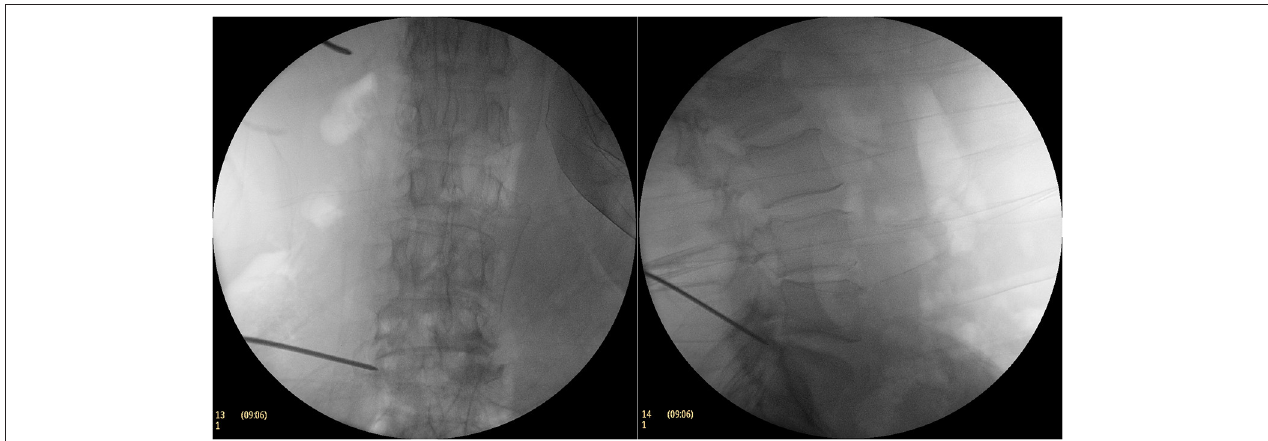
FIGURE 2 | During the operation, Kirschner needle puncture C-arm fluoroscopy. The anchor point of the Kirschner needle was close to the ventral edge of the superior articular process on the lateral fluoroscopic image and the tip of the Kirschner needle was located on the lateral side of the superior articular process on the AP fluoroscopic image.